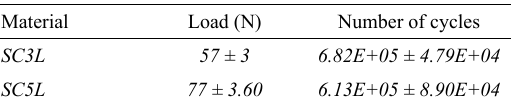
Table 3. Results of fatigue tests